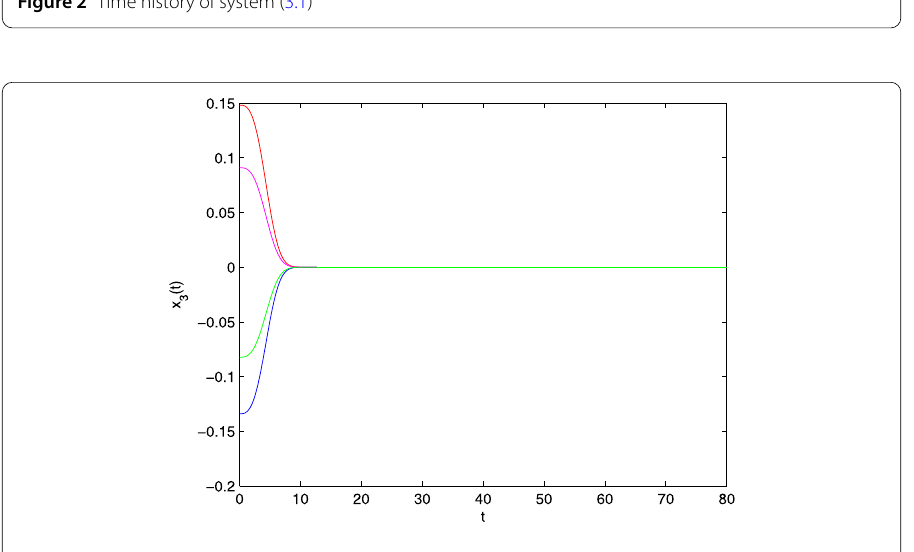
Figure 3 Time history of model